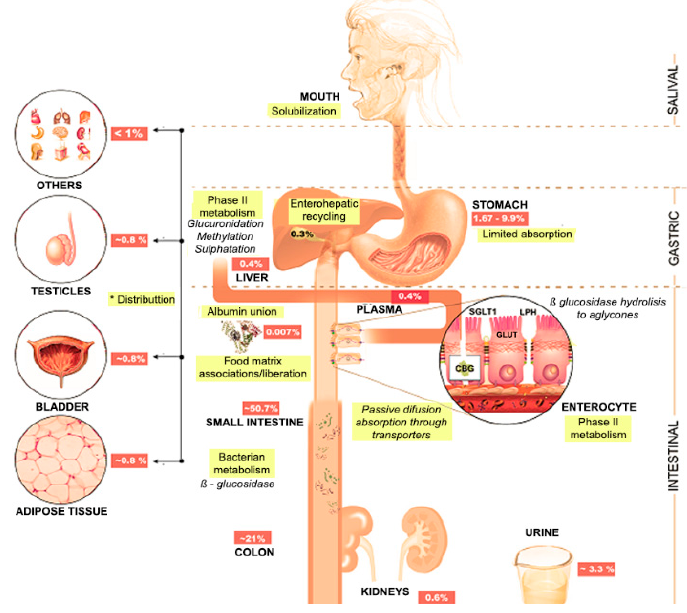
Figure 3. Cy3G metabolic fate in humans. Expressed as percentage of original Cy3G intake. See abbreviations section for the meaning of term.